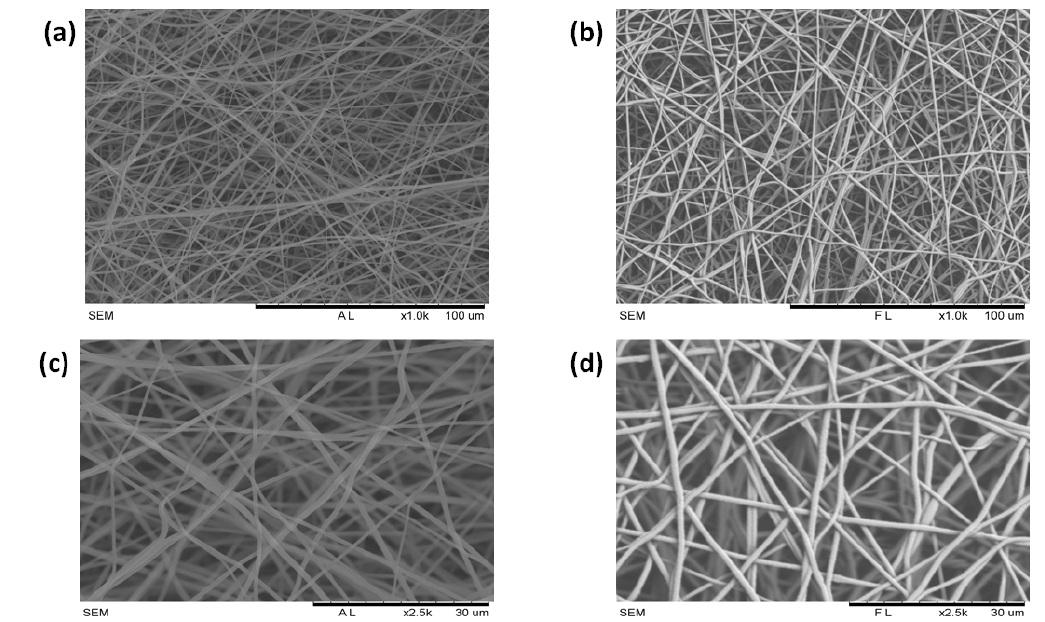
Figure 1. SEM images of (a) PU membrane (lower magnification) (b) PU/Amla oil nanocomposites (lower magnification) (c) PU membrane (higher magnification) (d) PU/Amla oil nanocomposites (higher